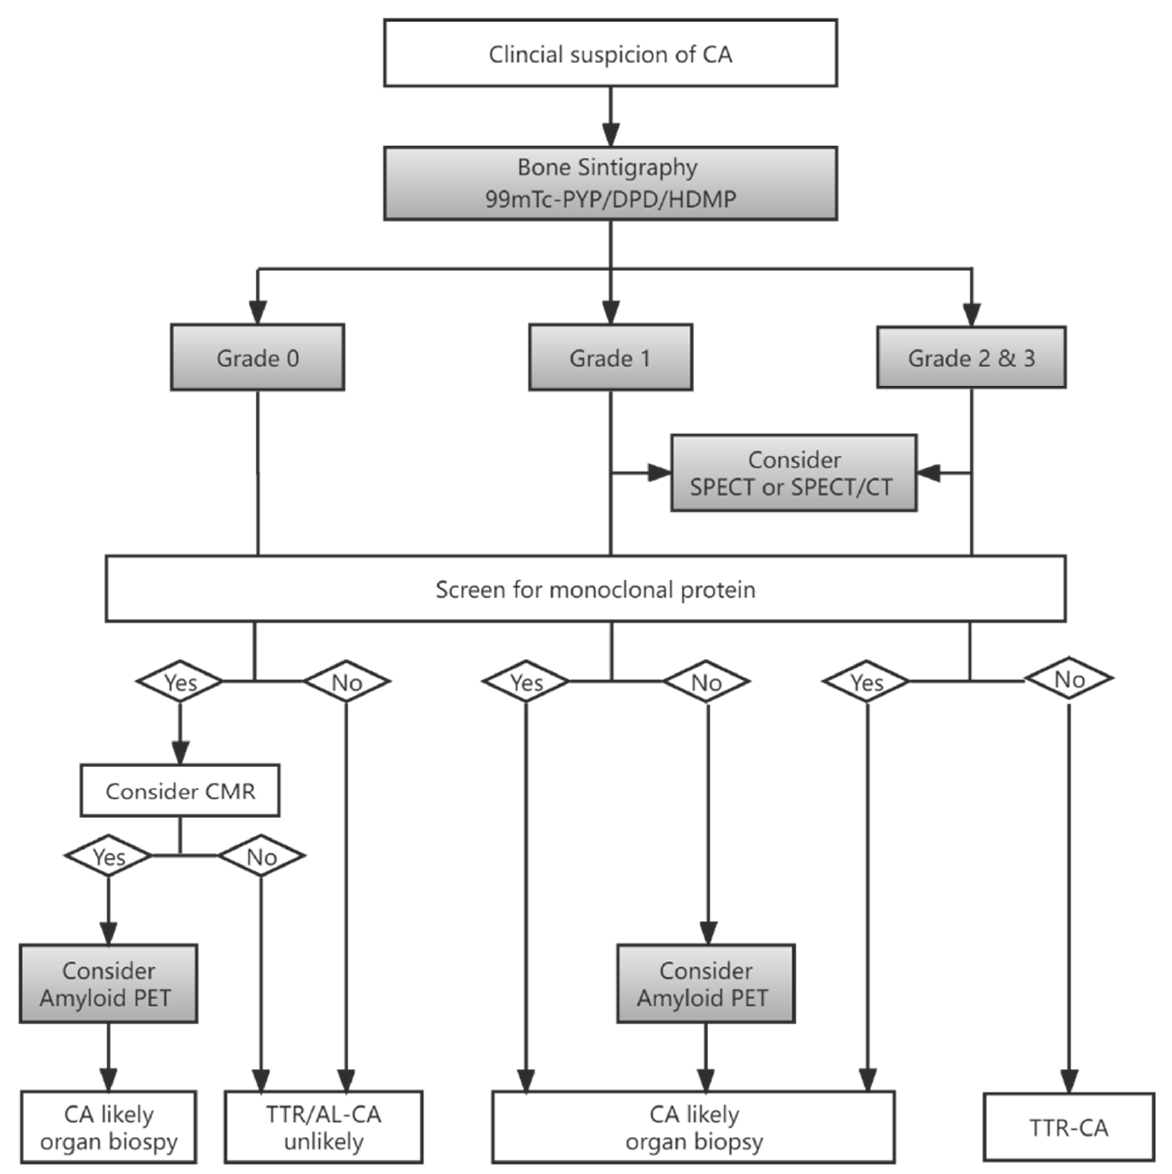
Figure 3. Flowchart for diagnosis of CA based on bone scintigraphy in patients with suspected CA (adapted data from [18,22]). CA = cardiac amyloidosis; TTR = transthyretin, AL = light-chain amyloidosis; SPECT/CT = single-photon emission tomography/computed tomography; PET = positron emission tomography; CMR = cardiac magnetic resonance.